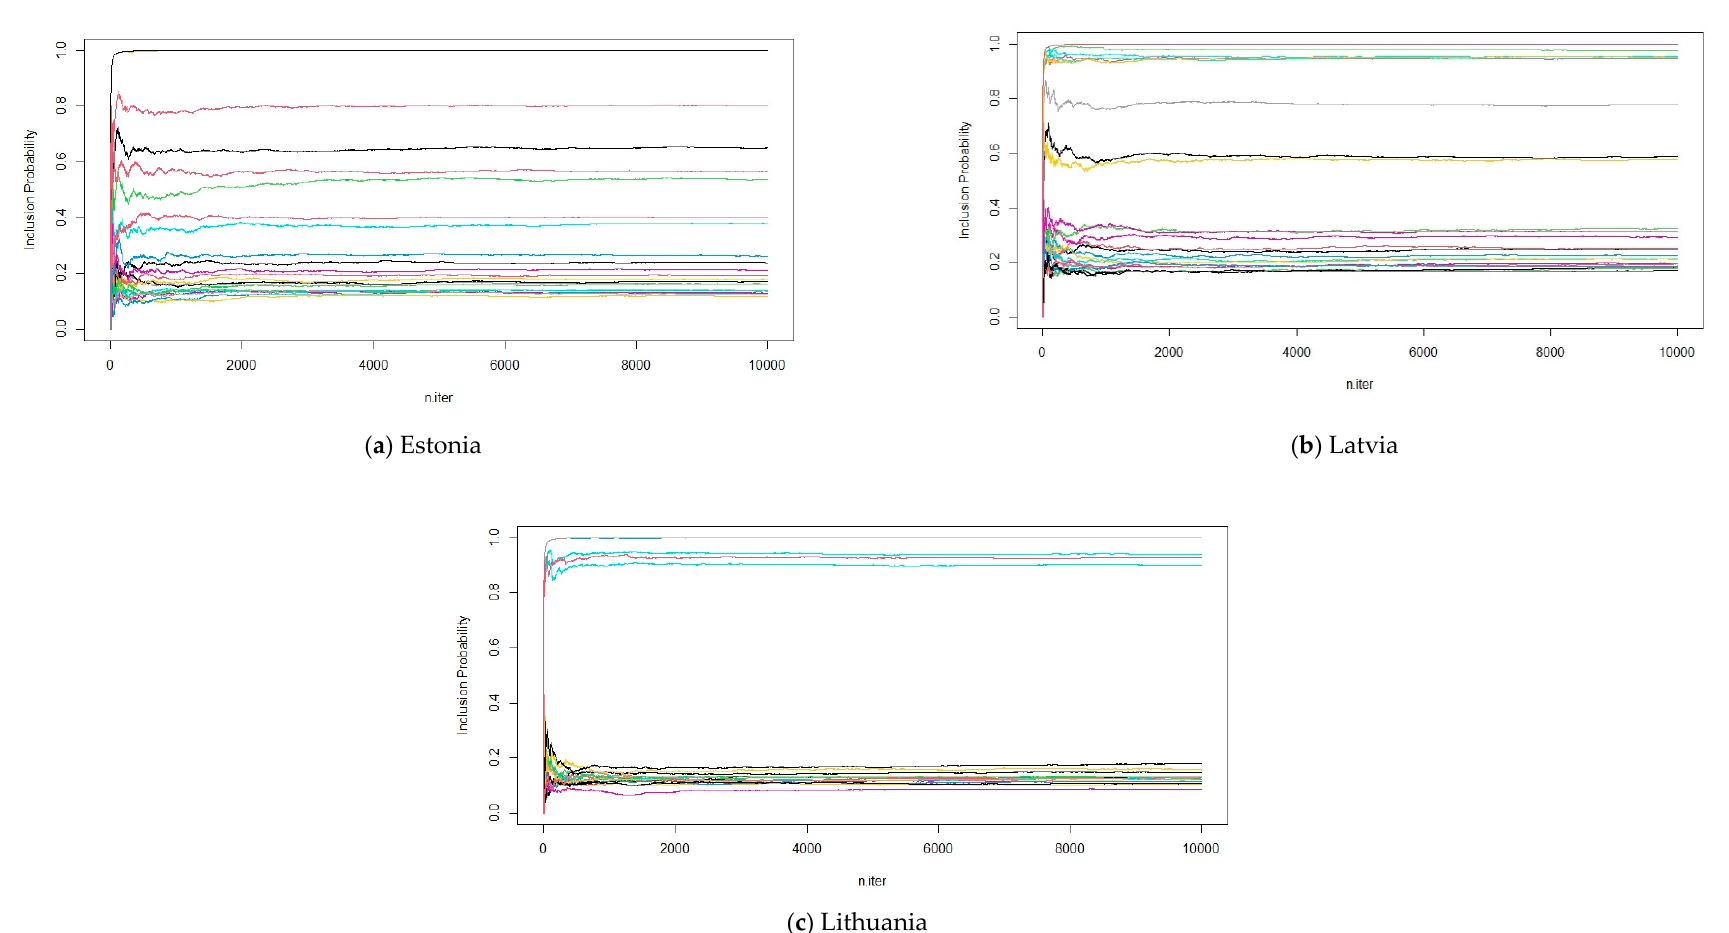
Figure A8. Evolution of the inclusion probabilities with the iterations in Gibbs sampling: Estonia, Latvia, Lithuania (general case).